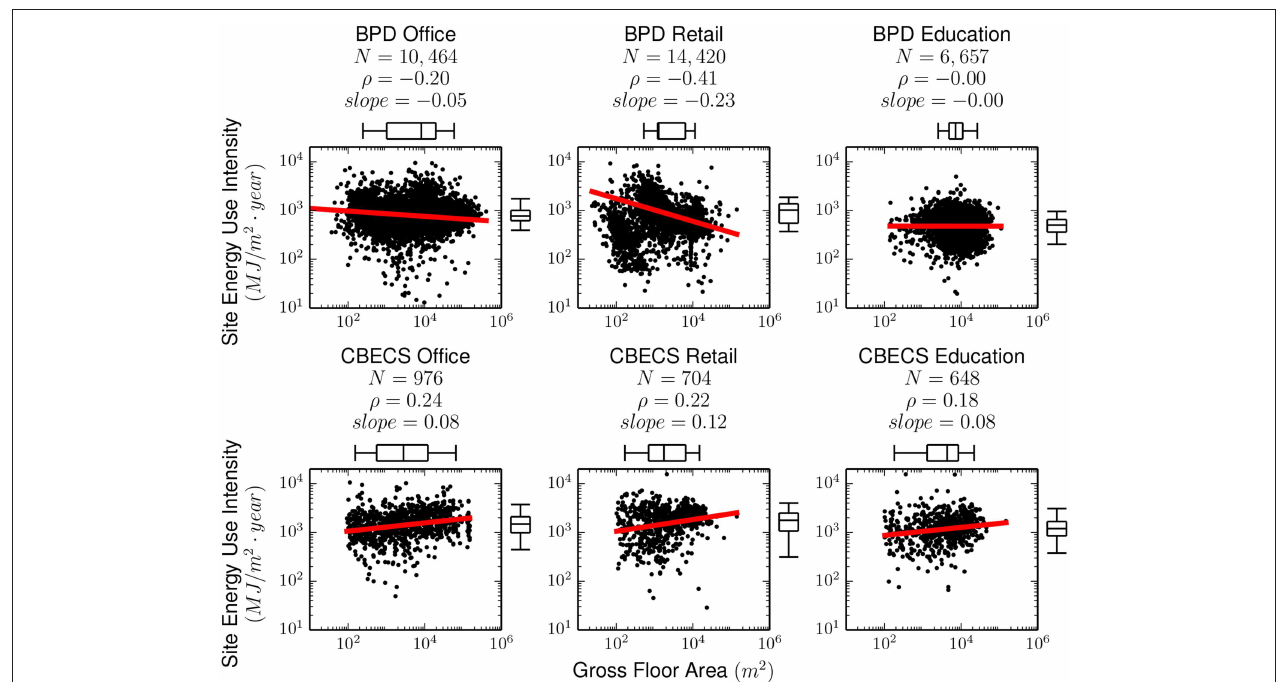
FIGURE 2 | Annual energy use normalized by gross floor area ( MJ / m 2 ) verses gross floor area ( m 2 ) for office, education and retail buildings in the Building Performance Database (BPD) and in CBECS. All figure elements are shared with Figure 1